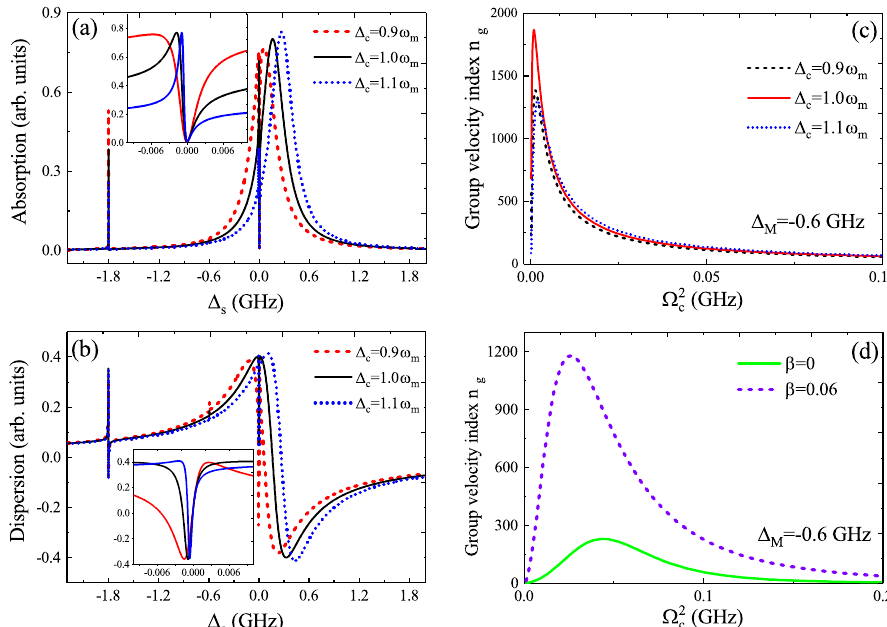
Figure 6. ( a , b ) The absorption and dispersion versus ∆ s for three ∆ c under the parameters of β = 0.06, g = 0.1 GHz, ∆ M = − 0.6 GHz, and Ω 2 c = 0.1 (GHz) 2 ; the insets are their details. ( c ) n g as a function of Ω 2 c for three ∆ c at ∆ M = − 0.6 GHz. ( d ) n g versus Ω 2 c in the condition of β = 0 and β (cid:54) = 0,